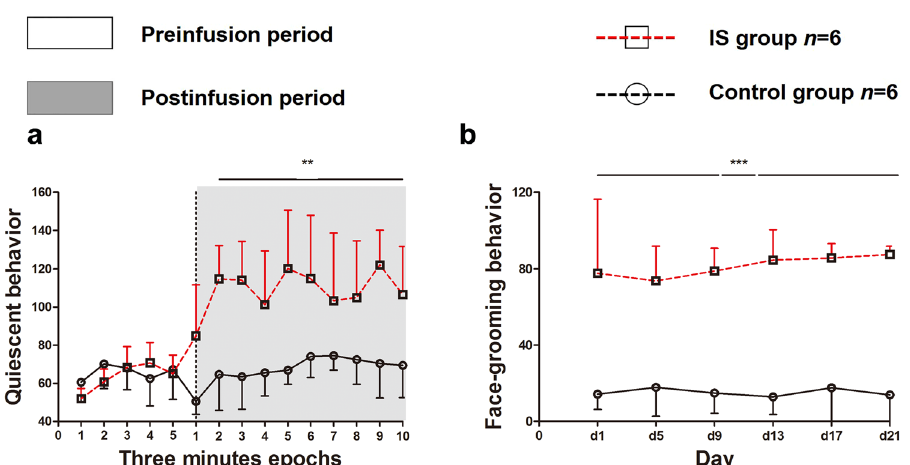
Figure 3. Nociceptive behaviors induced by IS. Average time spent in quiescent behavior ( a ) and face- grooming behavior ( b ) during the 21-day experiment. The mean ± the (SD) values are shown. ( a ) The figure shows the average time (in s) spent in quiescent behavior during the 21 days of the experiment, divided into the preinfusion period (15 min) and postinfusion period (30 min). The shading shows the postinfusion period. Each period was analysed in blocks of 3 minutes and was measured in s. ( b ) The picture shows the average time (in s) spent in face-grooming behavior, which was analysed every 4 days during the 30 min after IS or saline infusion. The IS group showed a significant increase in quiescent behavior compared with the Control group in the postinfusion period and an increase in facial grooming behavior in the day-by-day analysis ( ** P < 0.01, *** P < 0.001). IS, inflammatory